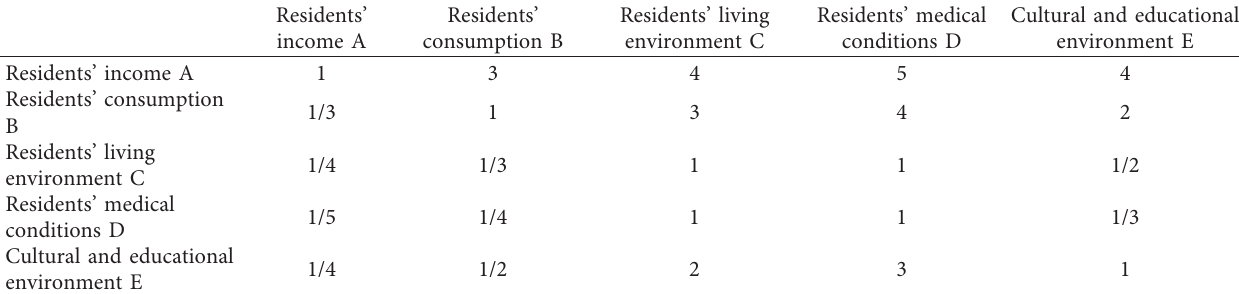
Table 3: Pairwise judgment matrix of first-level indicators.